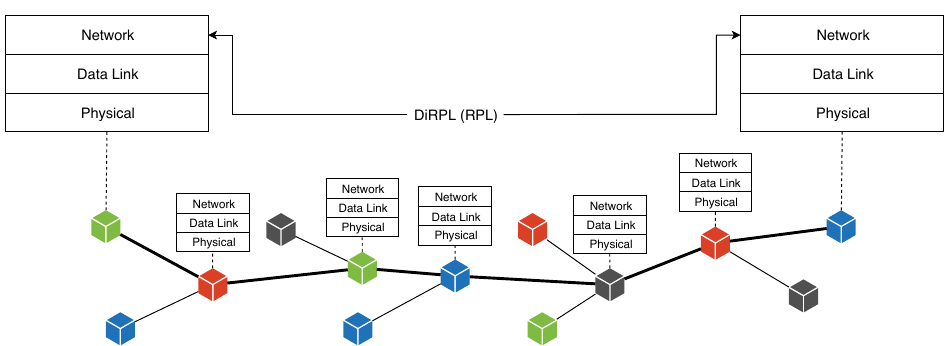
Figure 13. Detail on the ISO layers to be traversed by traffic flows with the proposed DiRPL